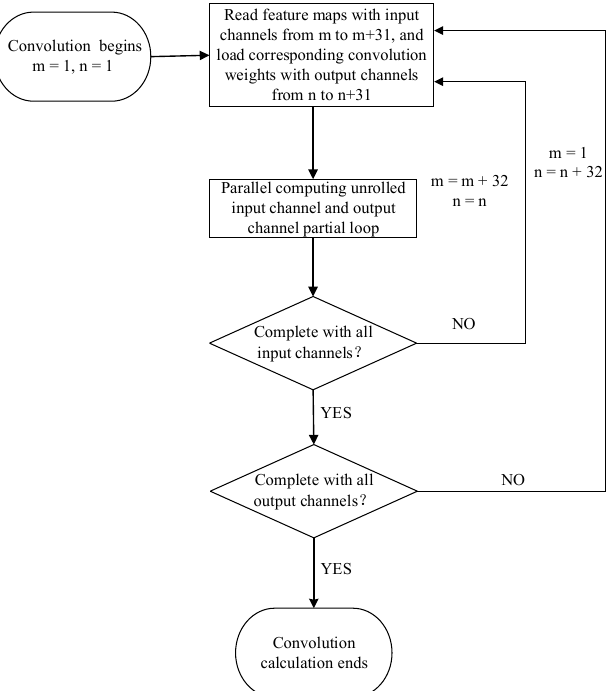
Figure 8. Flow chart of the loop calculation sequence.